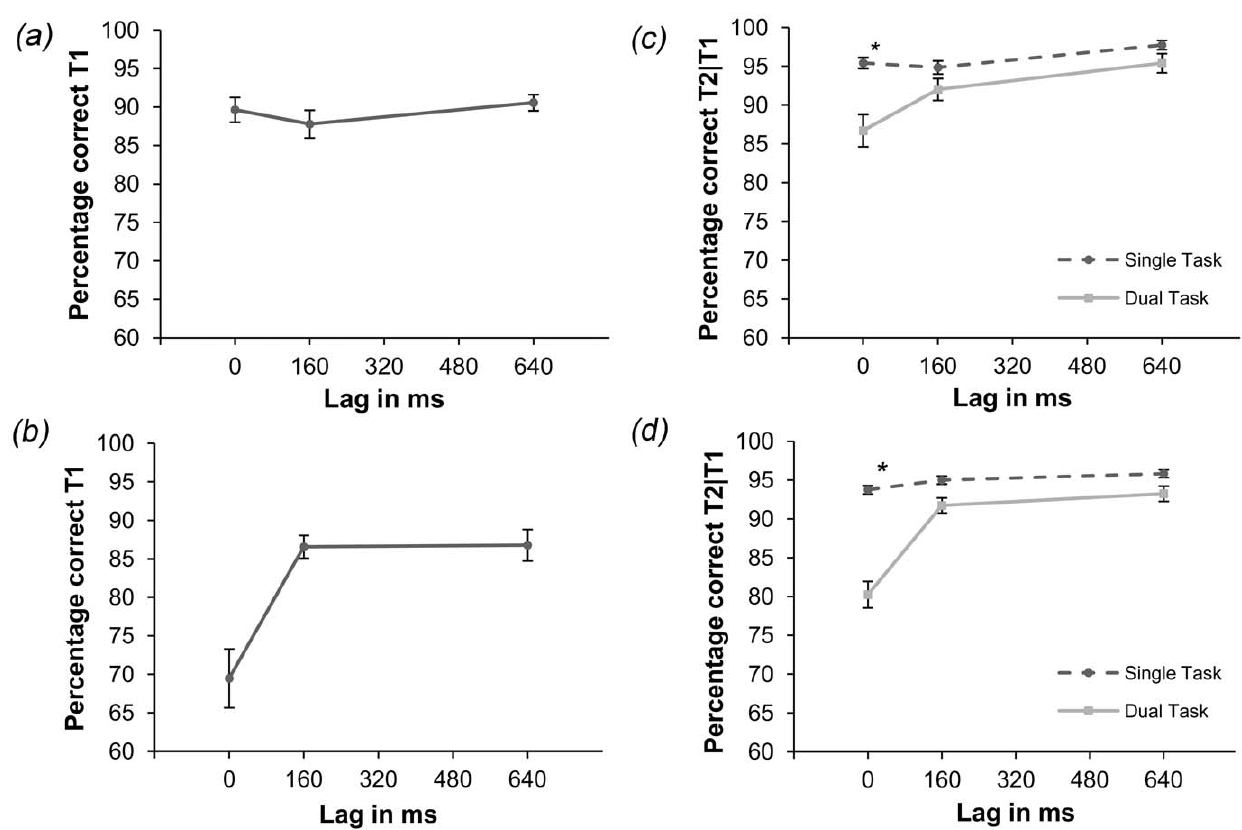
Figure 4. Results of Experiment 3. Panel (a) Percentage correctly identified letters in the dual-task condition of Experiment 3a. T1-identification was constant over all lags. Panel (b) Percentage correctly identified letters in the dual-task condition of Experiment 3b. Significantly less letters are correctly identified for lag 0 ms compared to lags 160 ms and 640 ms. Panel (c) T2-detection performance in percentage correct in the single- and dual-task conditions of Experiment 3a. Scores for the dual-task condition are for correct letter identification. Performance in the dual-task condition was significantly lower than in the single-task condition at lag 0 ms. Stars mark significant differences between single- and dual-task condition per lag (p , 0.05). Note that in this figure chance level is 50%. Panel (d) T2-detection performance in percentage correct in the single- and dual-task conditions of Experiment 3b. Scores for the dual-task condition are for correct letter identification. Performance in the dual-task condition was significantly lower than in the single-task condition at lag 0 ms. Stars mark significant differences between single- and dual-task condition per lag (p , 0.05). Note that in this figure chance level is 50%. Error bars reflect 95% confidence intervals in every panel.